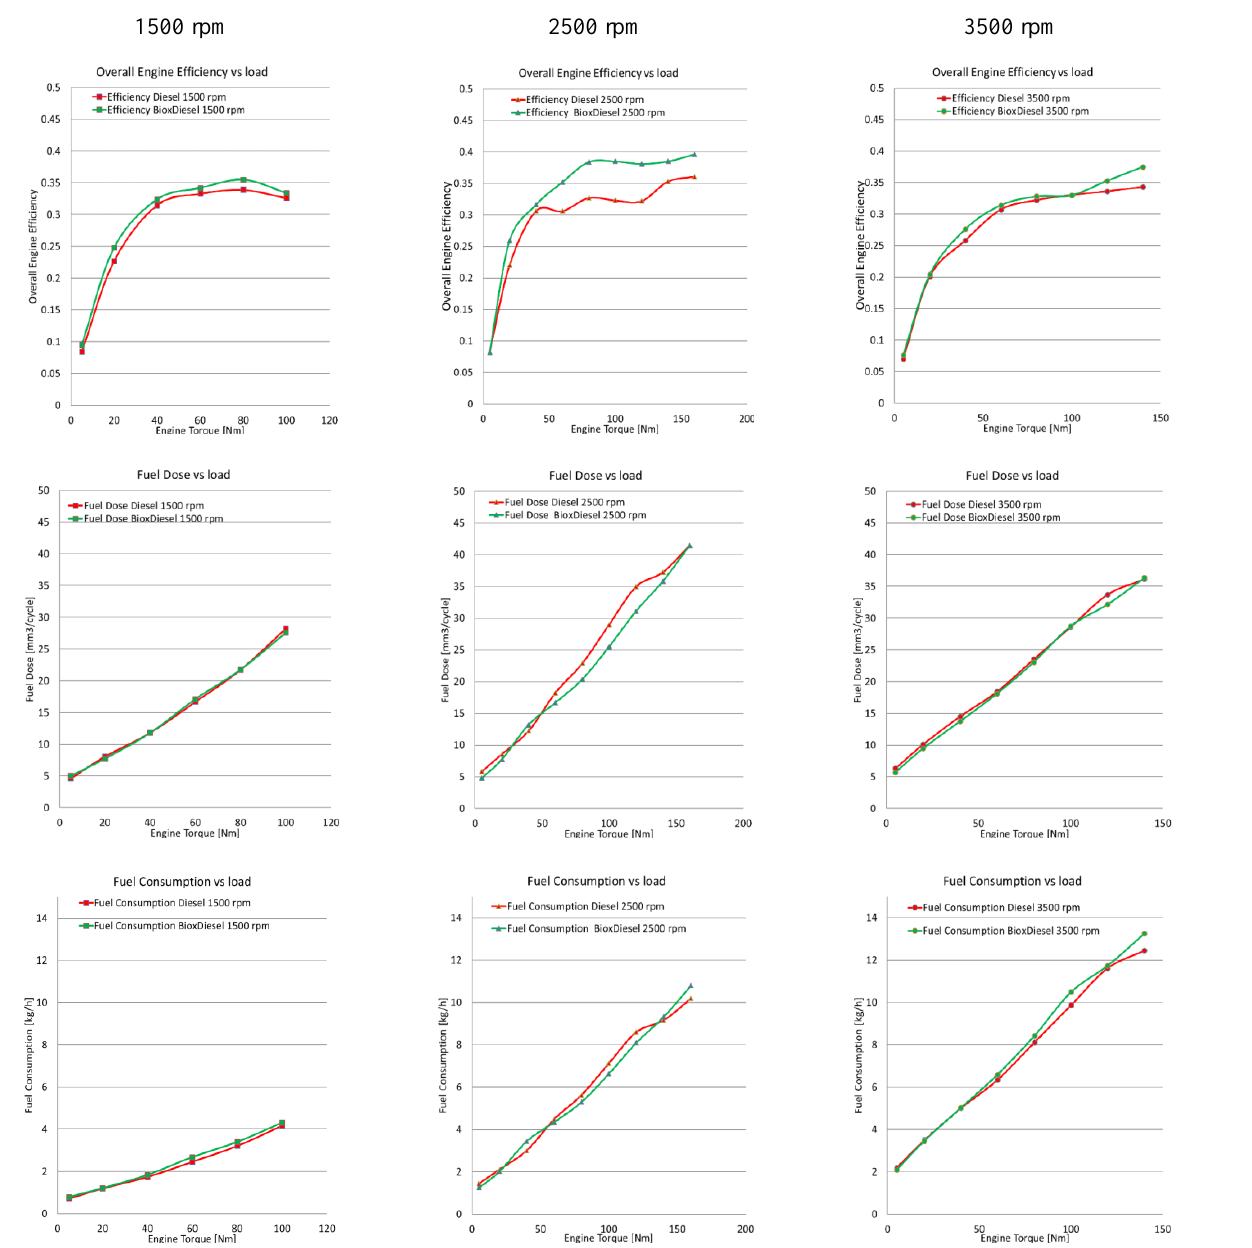
Fig. 9. Comparison of overall engine efficiency, fuel doses per cycle and engine fuel consumption at 1500, 2500, 3500 rpm in variable load of the engine fed with Bioxdiesel and